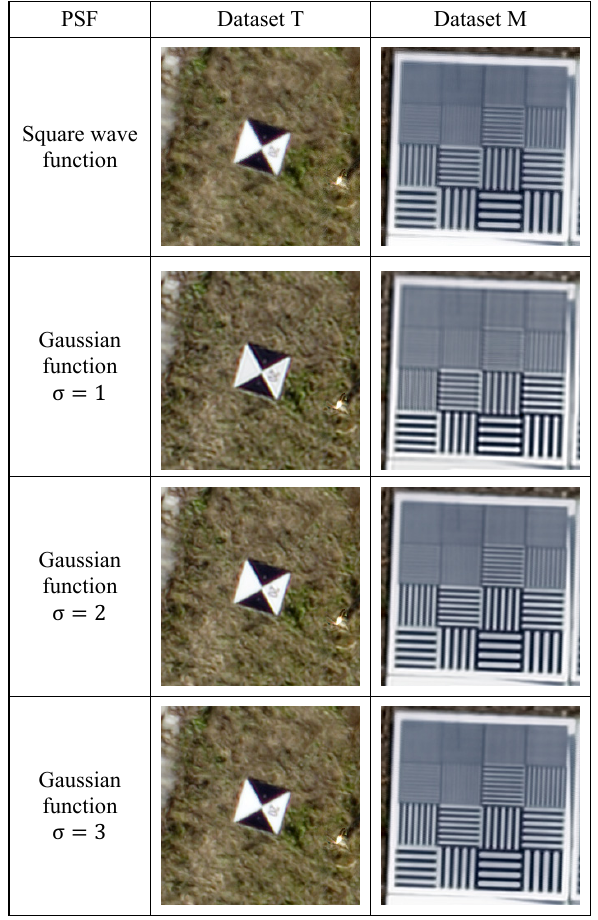
Figure 11. Results of SR-O by using